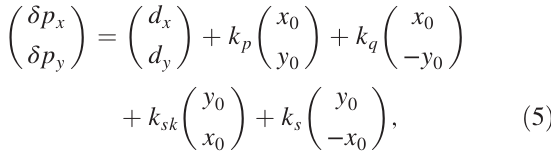
δ P ∥ is the increase ¯ G ≃ 15 MeV = m) and ∂ E z ð r ¼ 0 ;z Þ and B ϕ ¼ ∂ z 2